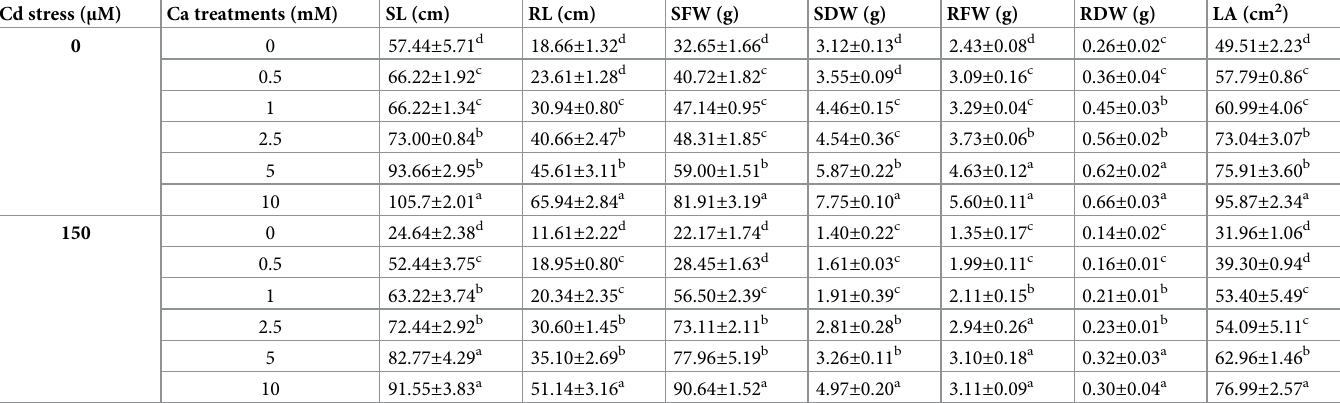
Means provided with error bars; in columns different letter indicates significance (P � 0.05) between treatments Abbreviation: Shoot length (SL) ; Root length (RL) ; Shoot fresh weight (SFW) ; Shoot dry weight (SDW) ; Root fresh weight (RFW) ; Root dry weight (RDW) ; Leaf area (LA)